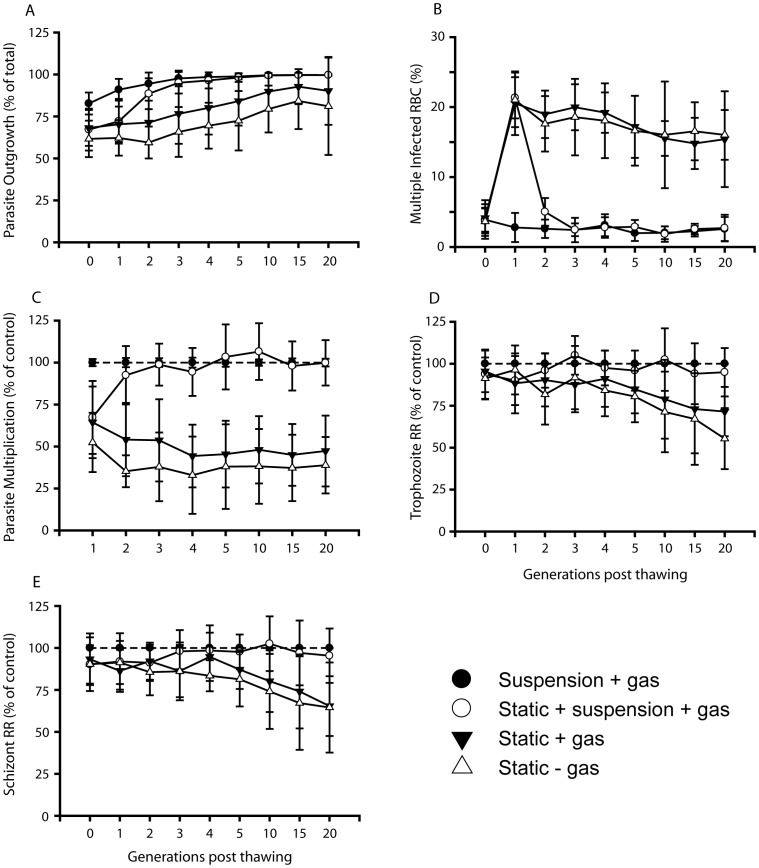
Parameters of patient isolates grown under different conditions.Improved parasite outgrowth and multiplication, lower frequency of multiple infected erythrocytes and preserved rosetting phenotype in isolates grown in suspension with fixed gas composition. Ten isolates, all subjected to four different in vitro growth conditions for twenty parasite generations, were scored for percentage viable (versus pyknotic) parasites (outgrowth) (A), rates of multiple infected RBCs (B), parasite multiplication rates (PMR) (C), trophozoite rosetting rates (TRR) (D) and schizont rosetting rates (SRR) (E). The different conditions were 1) growth in suspension (50 rev/min) with fixed gas composition (5% O2 and 5% CO2 in N2) (•), 2) the same but with first generation grown under static conditions (○), 3) static growth with fixed gas (▾) and 4) static growth with candle jar technique (Δ). Data are presented as mean values of the ten isolates and error bars represent standard deviations. For full multiple pairwise comparisons of the four culturing conditions for each generation, please see Figure S1.